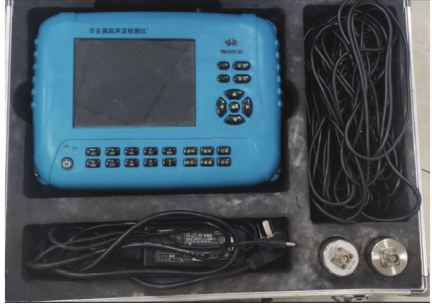
Figure 3: Nonmetal ultrasonic monitoring